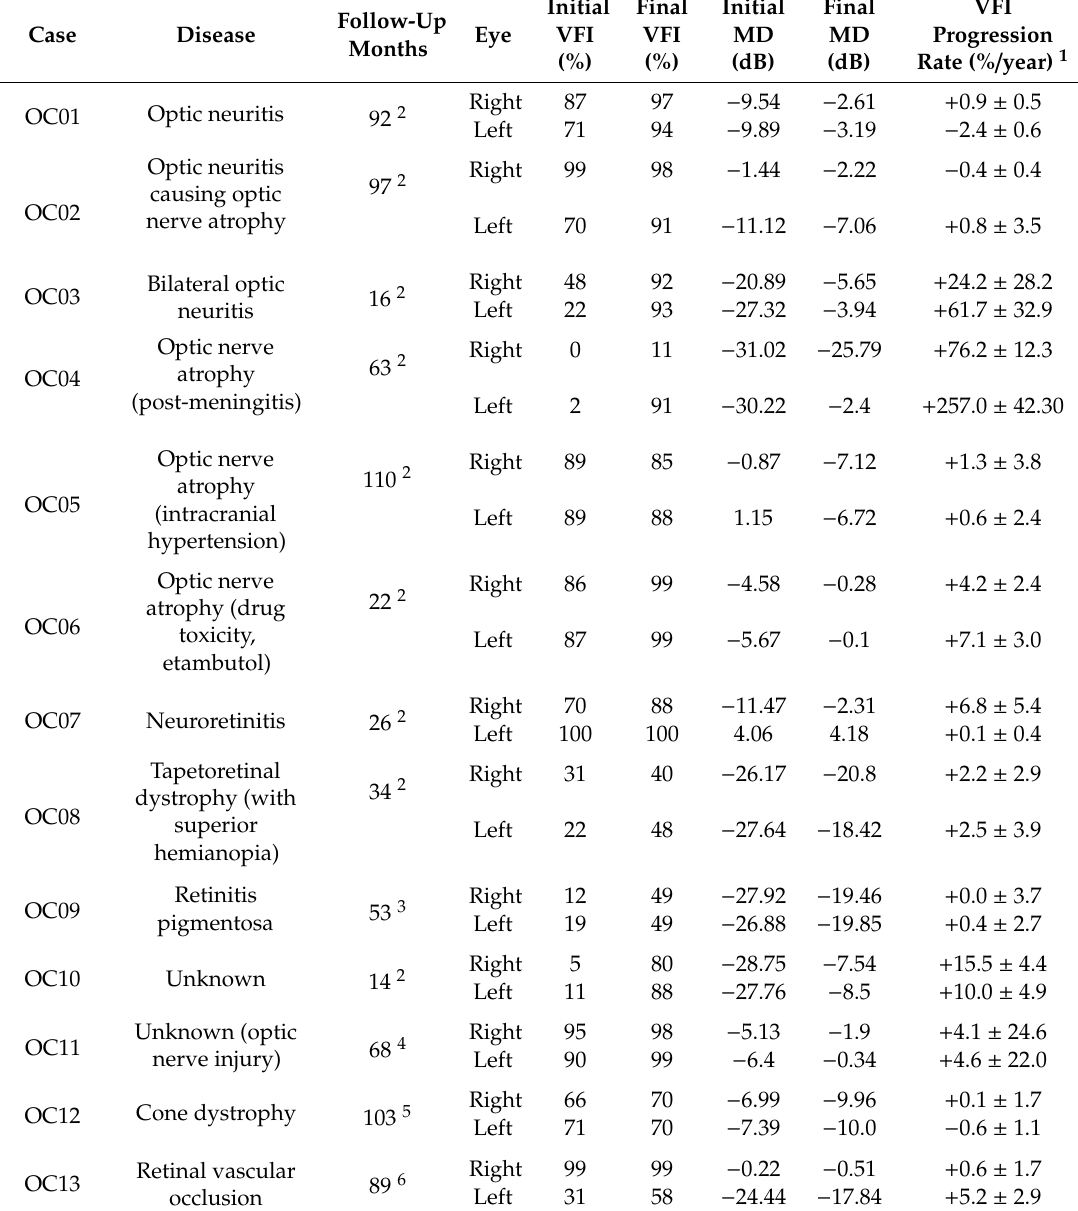
Table 5. Clinical characteristics of patients with other conditions, VFI and MD follow-up, and progression